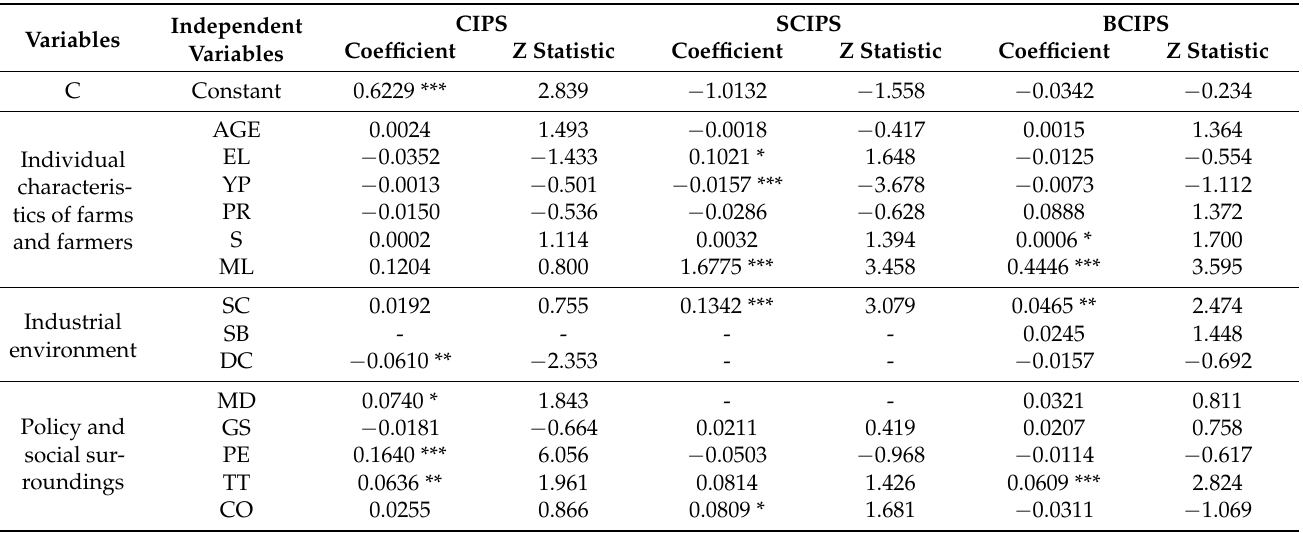
Table 6. Estimation Results of the Factors Influencing the Technical Efficiency (TE) of Different Beef Calf Production